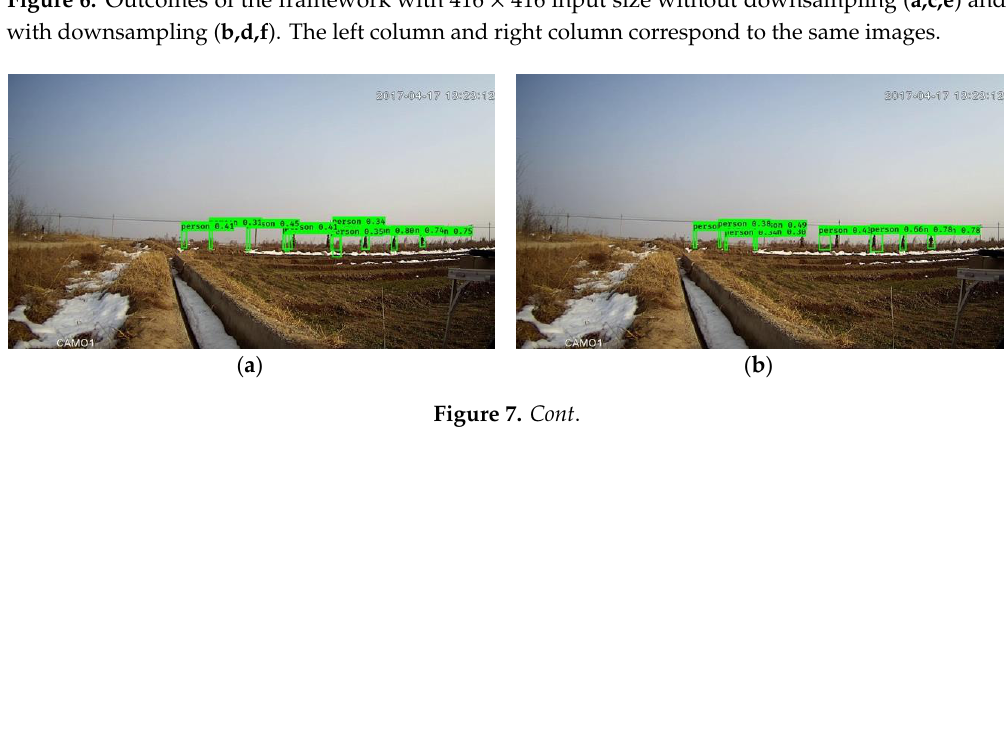
Figure 6. Outcomes of the framework with 416 × 416 input size without downsampling ( a,c,e ) and with downsampling ( b,d,f ). The left column and right column correspond to the same images. Table 6. Results of the framework with focal loss, with and without downsampling on different input sizes.